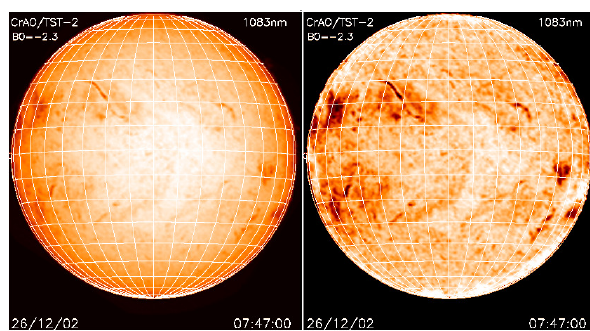
Figure 4. Full-disk images of the Sun obtained on December 26th, 2002 in the He I 1083 nm line